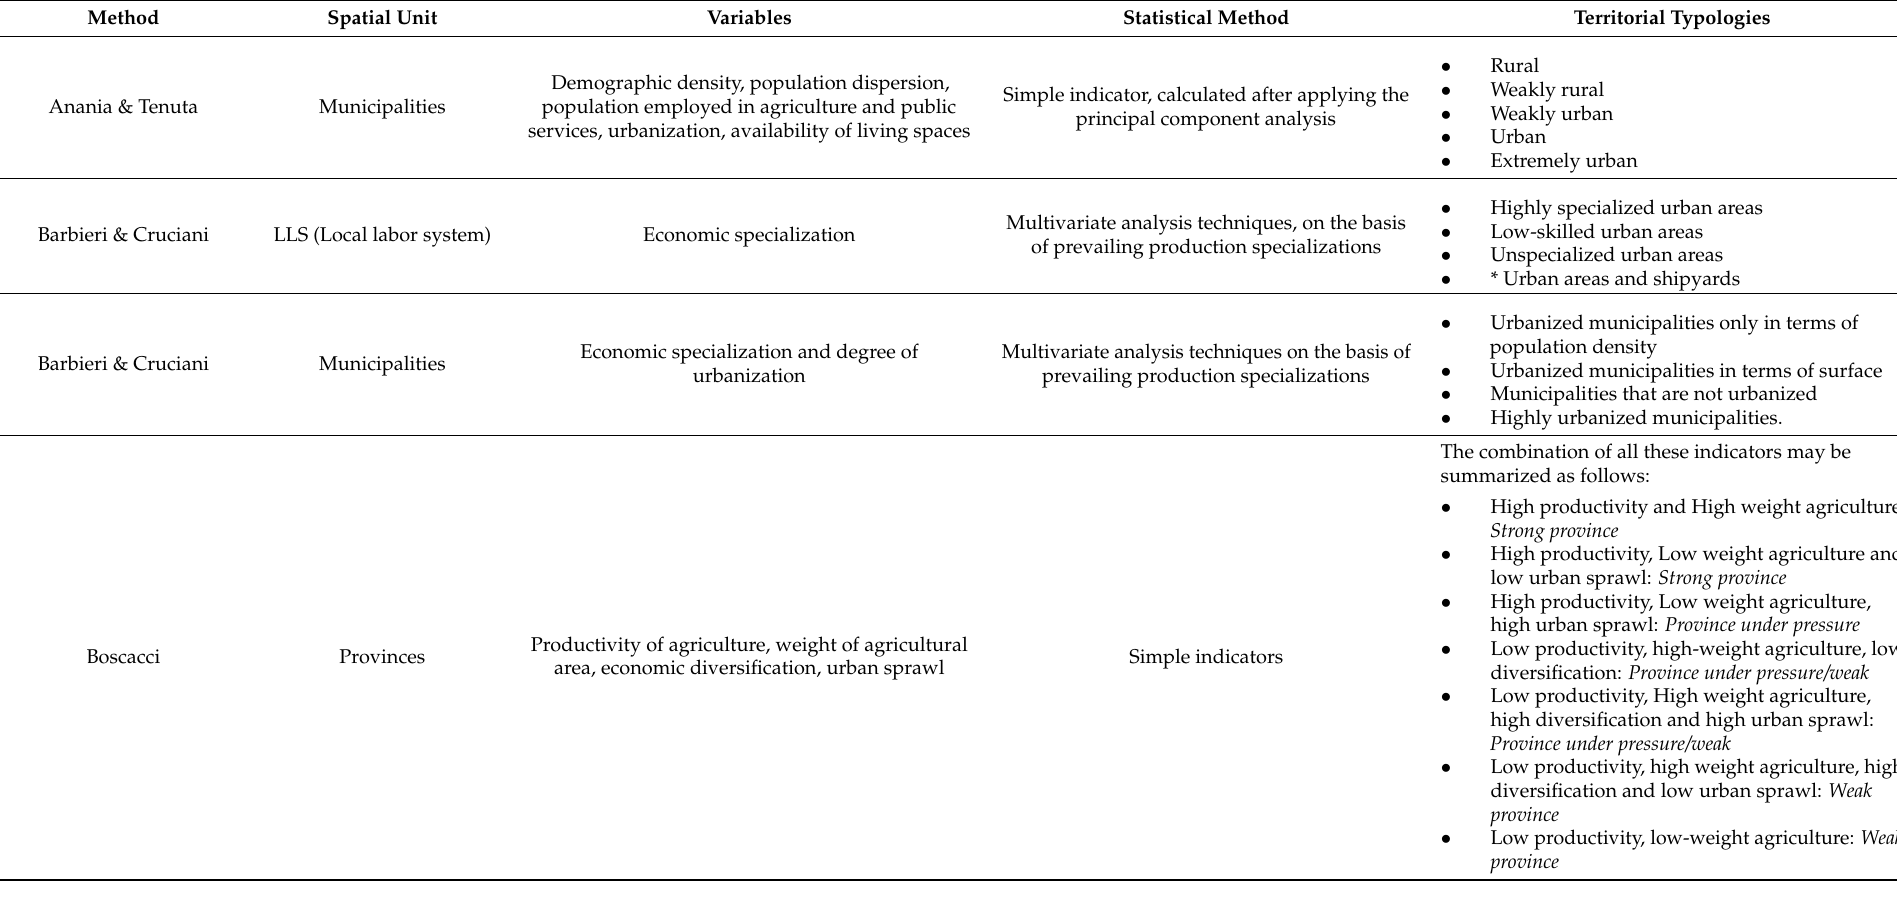
Table 2. Summary of the methods considered. Source: own elaboration based on literature